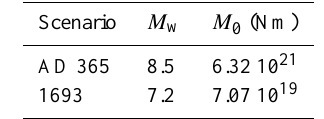
Table 1. Magnitude M w and seismic moment M 0 for the two sce- narios as determined by Tonini et al. (2011).